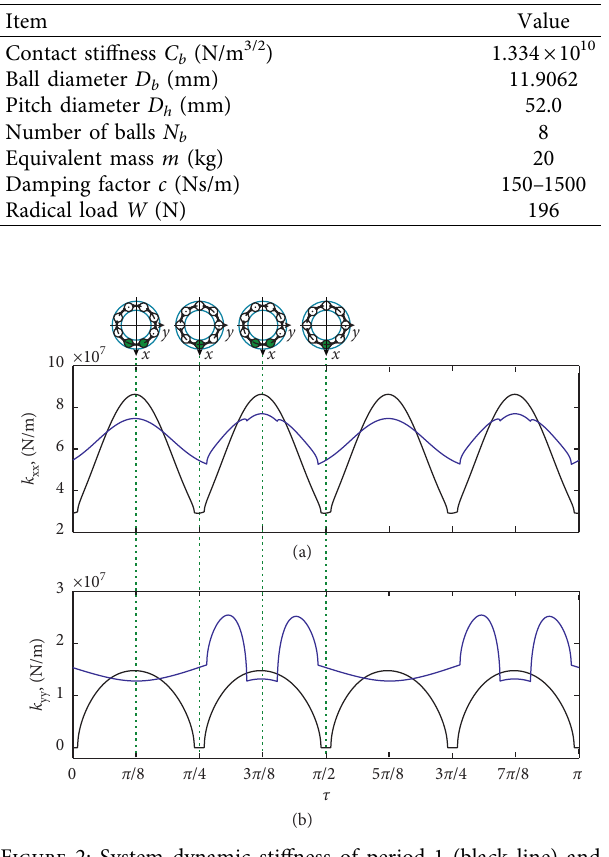
Table 1: Specifications and parameters of JIS6306 ball bearing.